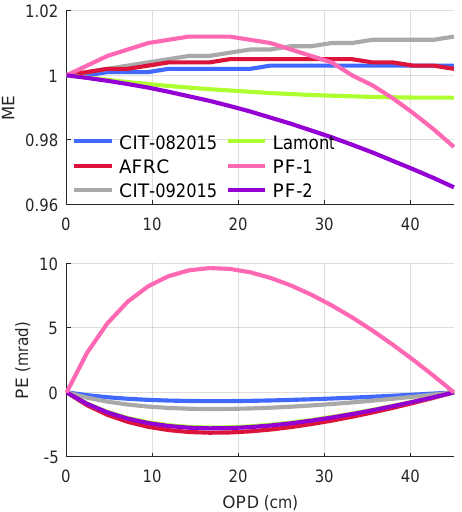
Figure 7. Modulation efficiency and phase error for each of the 125HR instruments describe the ILS. Results are calculated from HCl lines using LINEFIT 14.5 on monthly averages of internal lamp spectra. For Caltech, 2 different months are shown and Park Falls-1 corresponds to August 2015 and Park Falls-2 corresponds to Octo- ber